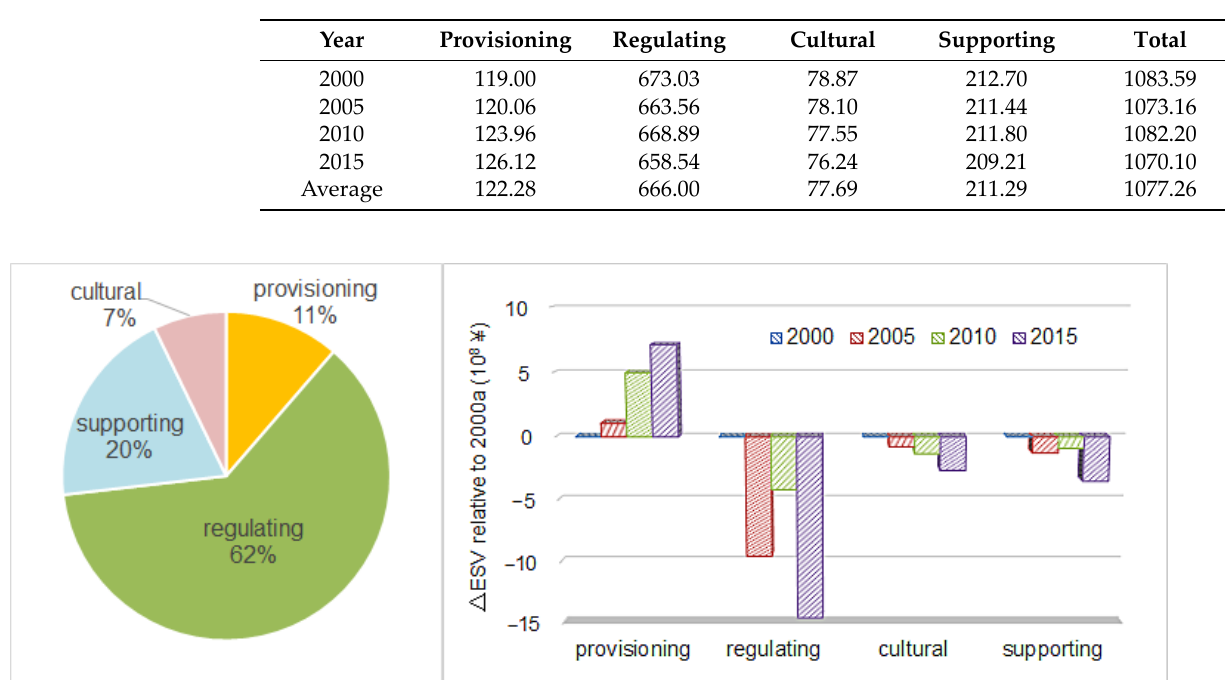
Figure 7. Proportions ( left ) and relative annual dynamics ( right ) of ESVs.